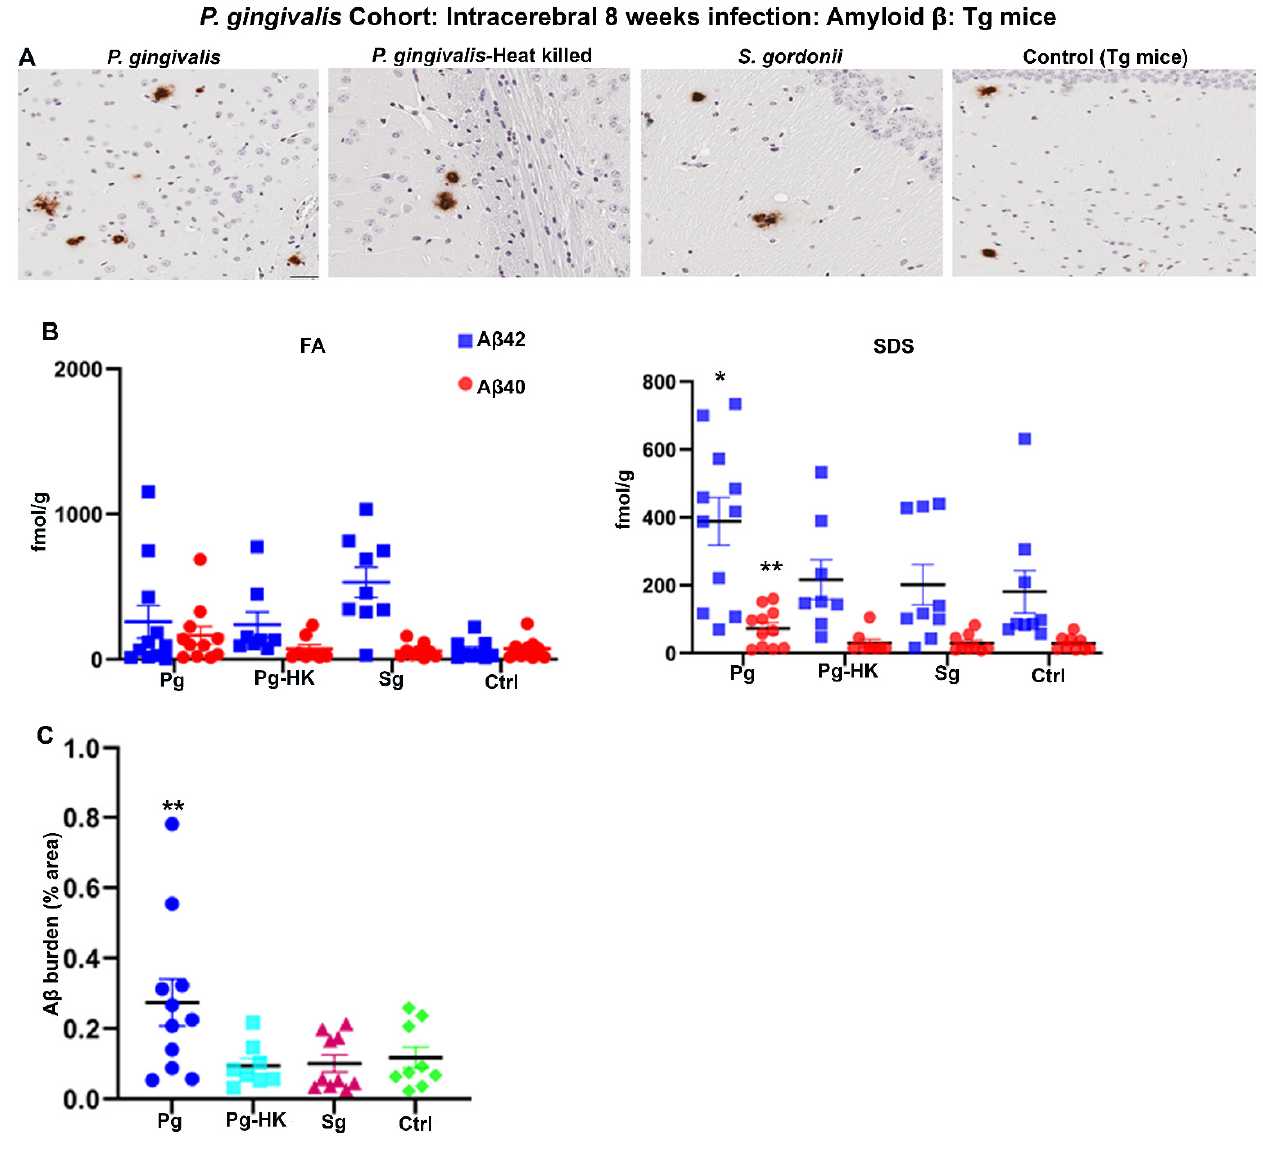
Figure 3. Hippocampal intracerebral infection of P. gingivalis for 8 weeks induced significant A β levels and A β plaque burden in Tg mice: P. gingivalis cohort. ( A ) Representative brain sections of the Tg mice infected with P. gingivalis , HK P. gingivalis , S. gordonii , and sham-infection Tg mice were immunostained for amyloid β plaques (scale bar-200 µ m). ( B ) A β 42 and A β 40 levels in brain extracts from bacterial and sham-infected Tg mice solubilized in FA and SDS analyzed by human A β end- specific sandwich ELISA ( n = 8–11). Significant increases in SDS-42 (* p < 0.1) and SDS-40 (** p < 0.05) were found in P. gingivalis infected Tg mice compared to the PBS infected Tg mice (Ordinary one-way ANOVA, Dunnett’s multiple comparison test). ( C ) Amyloid β burden was significantly higher in Tg mice intracerebrally infected with P. gingivalis compared to the sham-infected Tg mice. Amyloid β burden was calculated using the Positive Pixel Count Program (Aperio). (Ordinary one-way ANOVA, Dunnett’s multiple comparison test ** -Adjusted p value = 0.045).